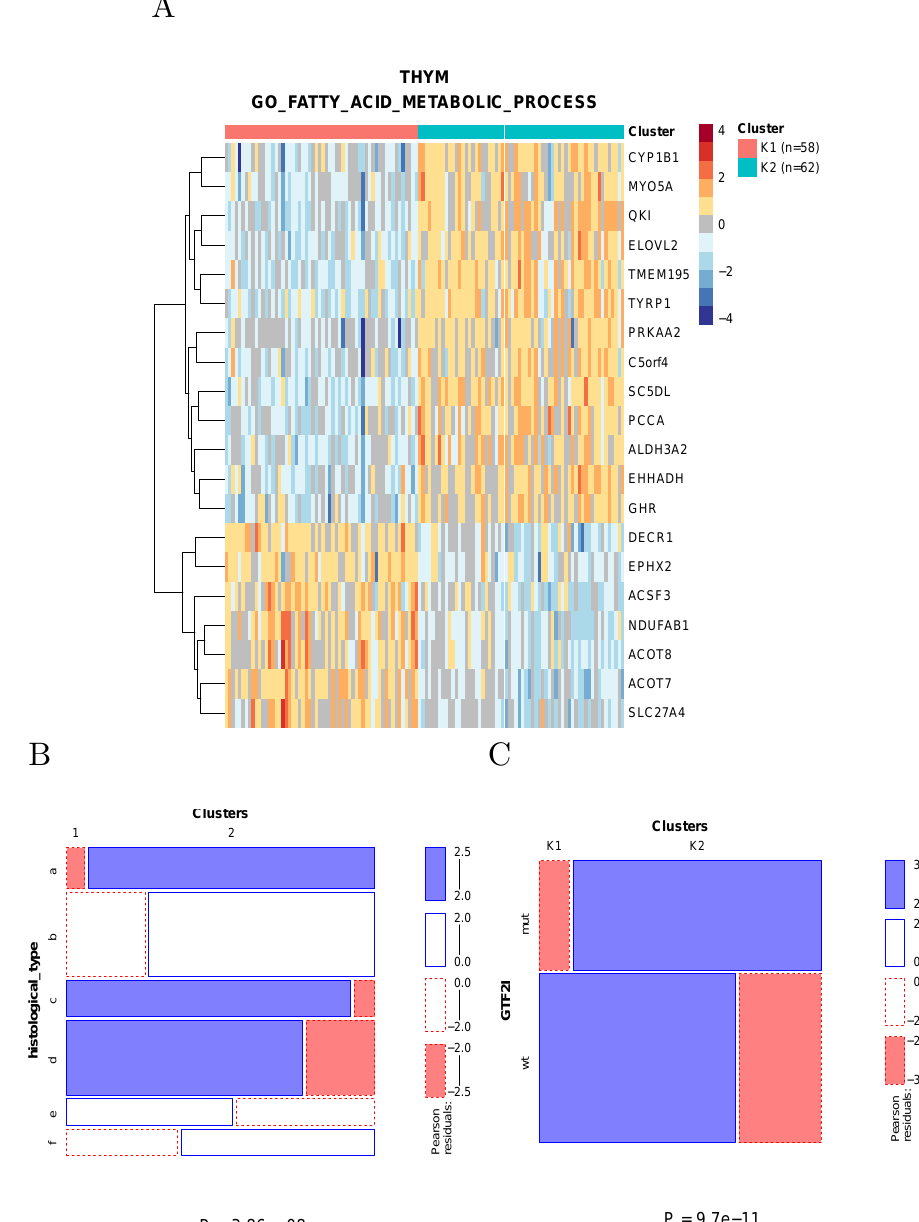
Figure 7. ( A ) Clustering of thymoma samples using the genes associated by KEGG to fatty acid metabolism. ( B ) The clusters significantly overlap the known histological types; (a): thymoma, type a; (b): thymoma, type ab; (c): thymoma, type b1; (d): thymoma, type b2; (e): thymoma, type b3; (f): thymoma, type c. ( C ) GTF2I mutations significantly segregate between the two